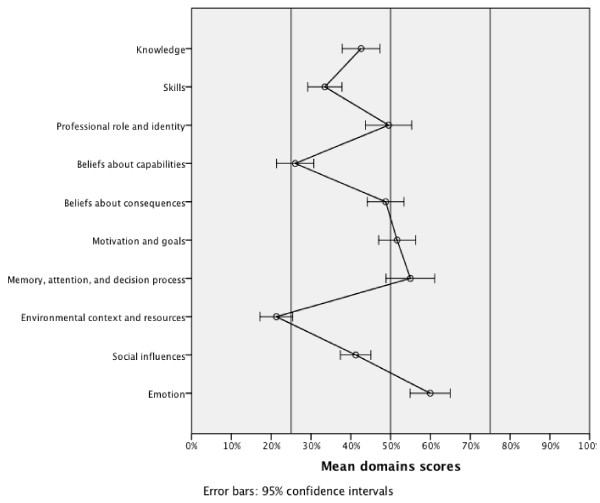
The mean domain scores (total/maximum possible) with 95% confidence intervals (n = 73).